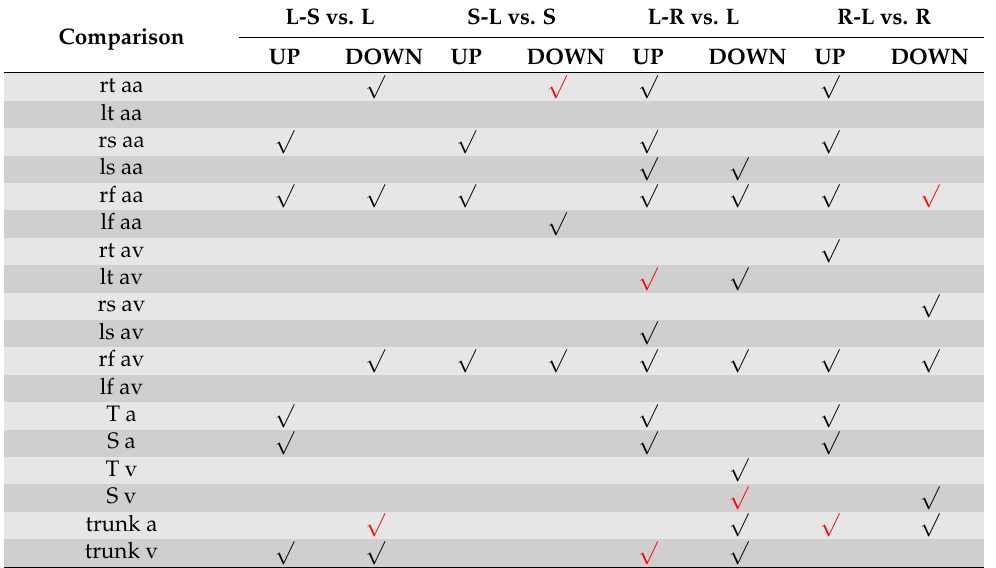
Table 8. Parameters with early significant differences in different gait pattern